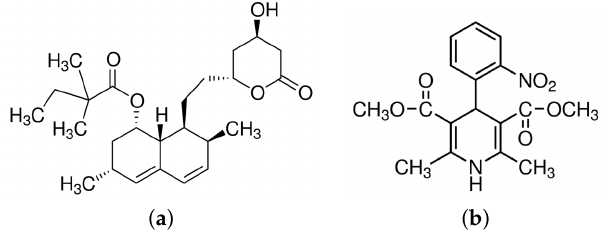
Figure 1. Chemical structures of active pharmaceutical ingredients ( a ) Simvastatin SIM (cholesterol lowering agent) and ( b ) Nifedipine NIF (calcium channel blocker used to treat